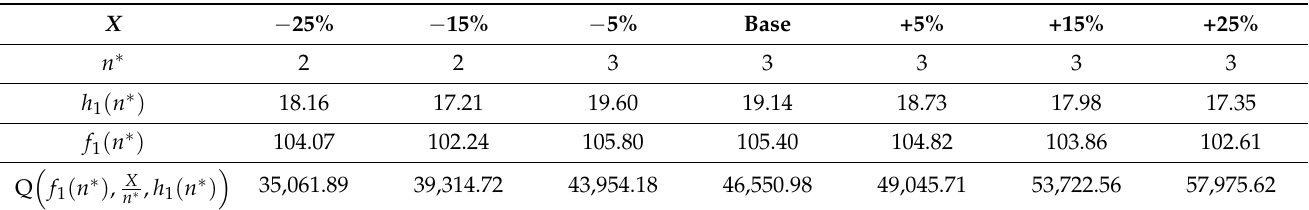
Table 12. Variation of the width of the service area X